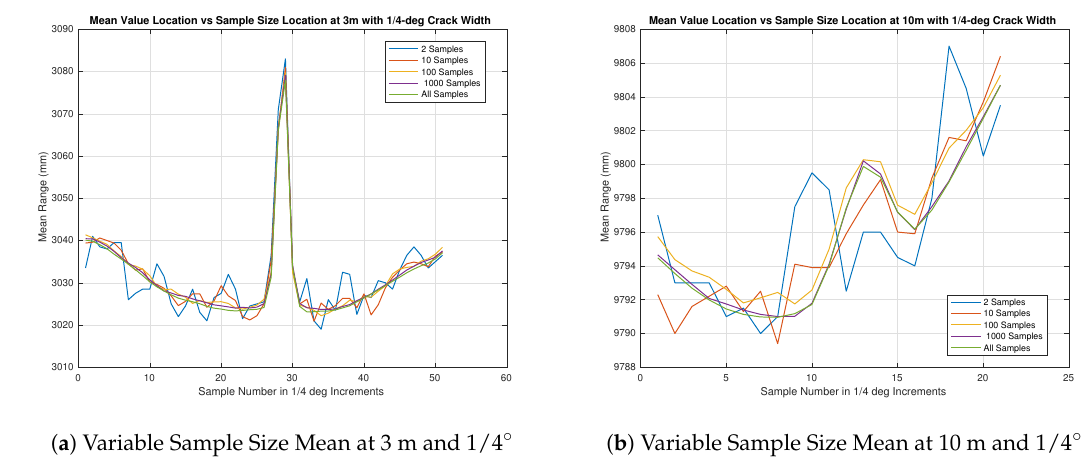
Figure 12. Comparison of angular resolution results between 3 m & 10 m range at a gap of 1/4 ◦ .